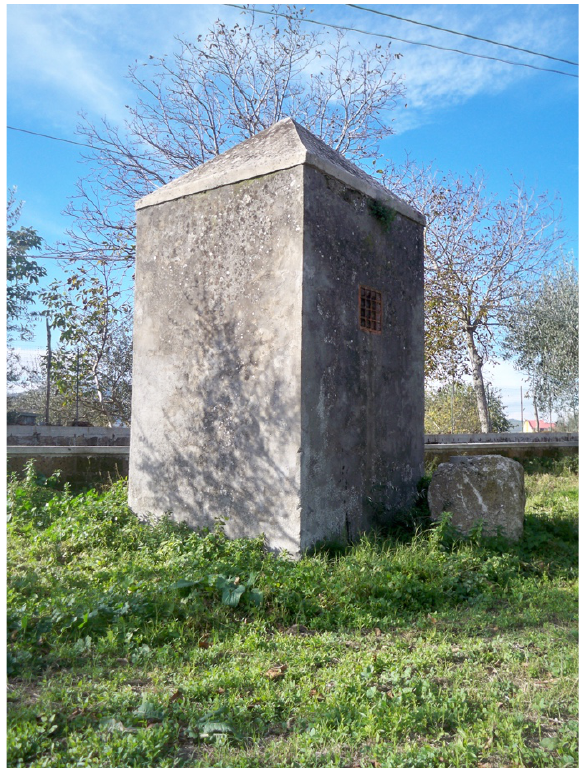
Figure 2 . ‘Carolino’ Aqueduct. Turret n.9.